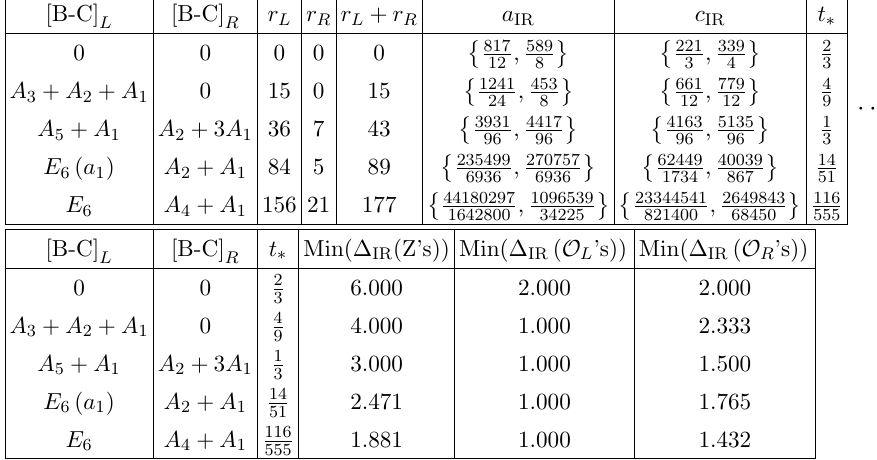
Table 22. Flipper (cid:12)eld deformations of ( E 7 , E 7 ) conformal matter, only rational